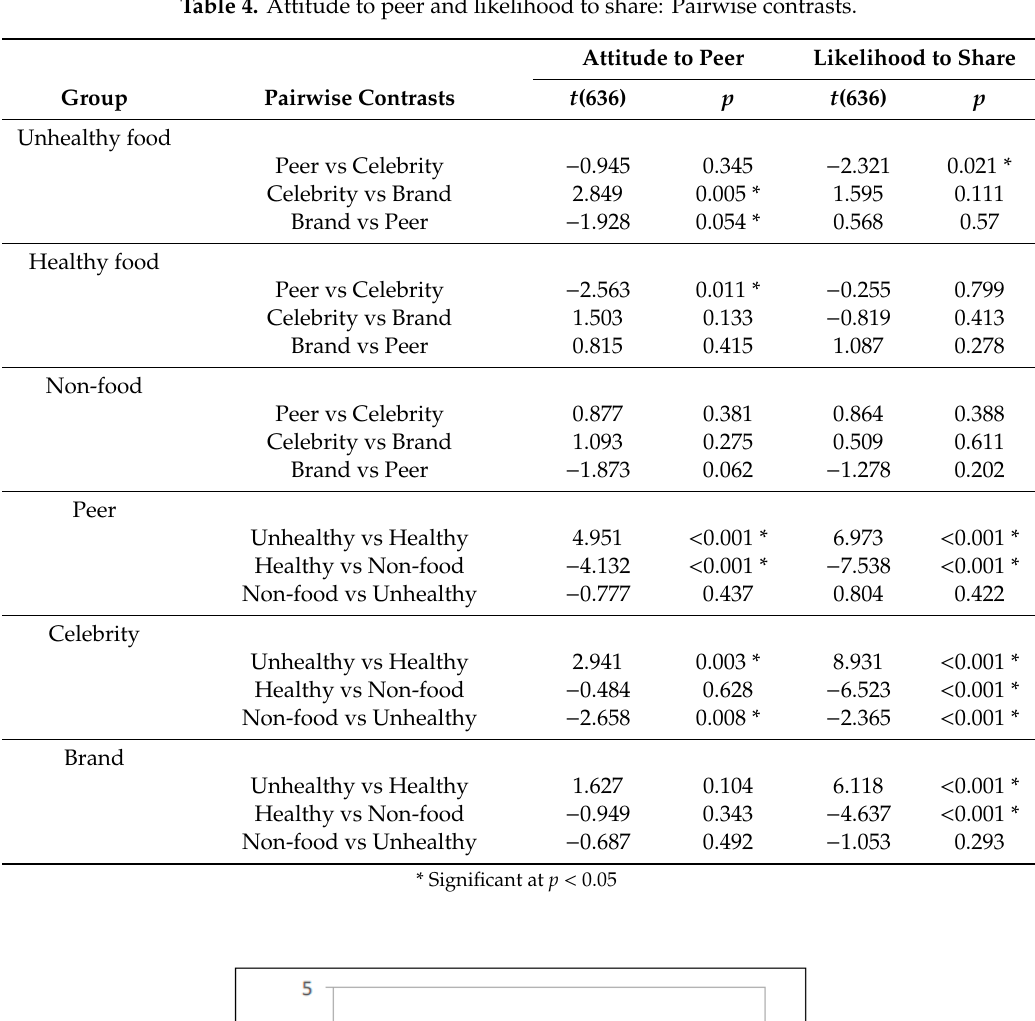
Table 4. Attitude to peer and likelihood to share: Pairwise contrasts.